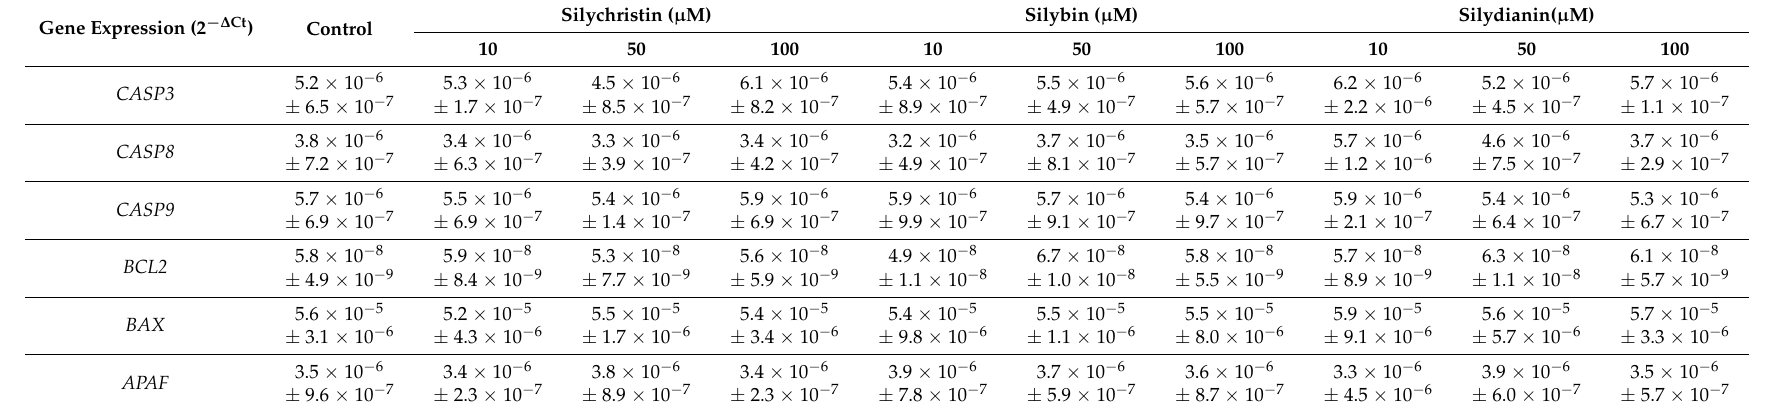
Table 1. The effect of flavonolignans (silychristin, silybin and silydianin in concentrations of 10, 50 and 100 µ M) on pro-apoptotic genes’ expression in the A549 cell line. The data represent means of ± SD, n =